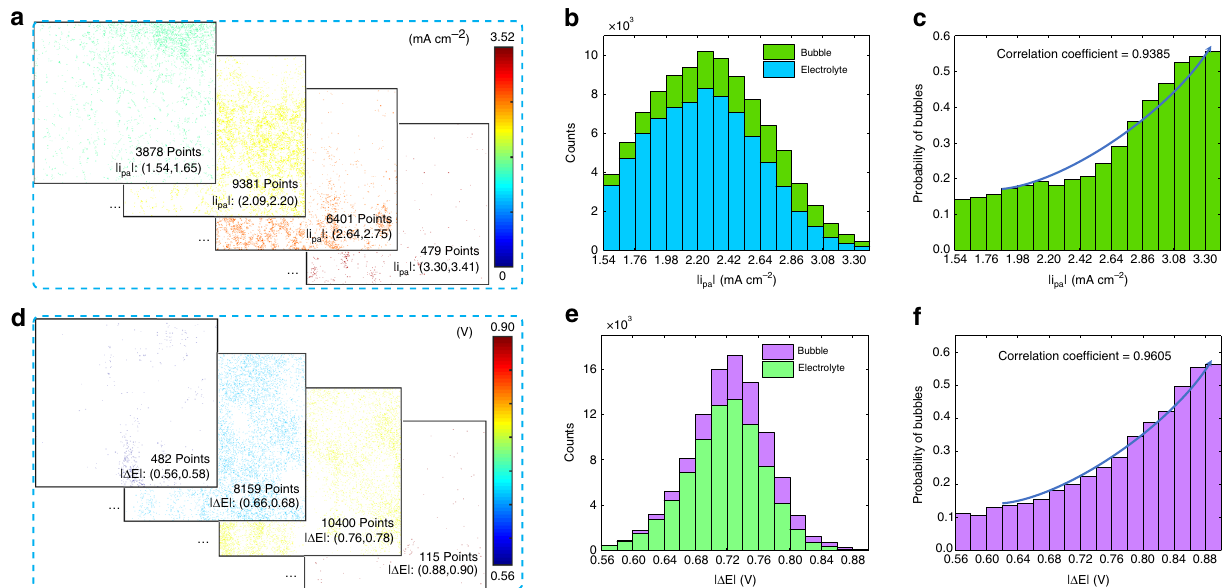
Fig. 6 Activity distribution and bubble distribution in long-term cyclic voltammetry. The | i pa | ( a ) and | Δ E | ( d ) mappings of different intervals excluding the fi ber contact regions at the 1st cycle. The count distribution of regions covered by electrolyte and by bubbles in 17 | i respectively. The probability of bubble generation in different | i pa | ( c ) and | Δ E | ( f )